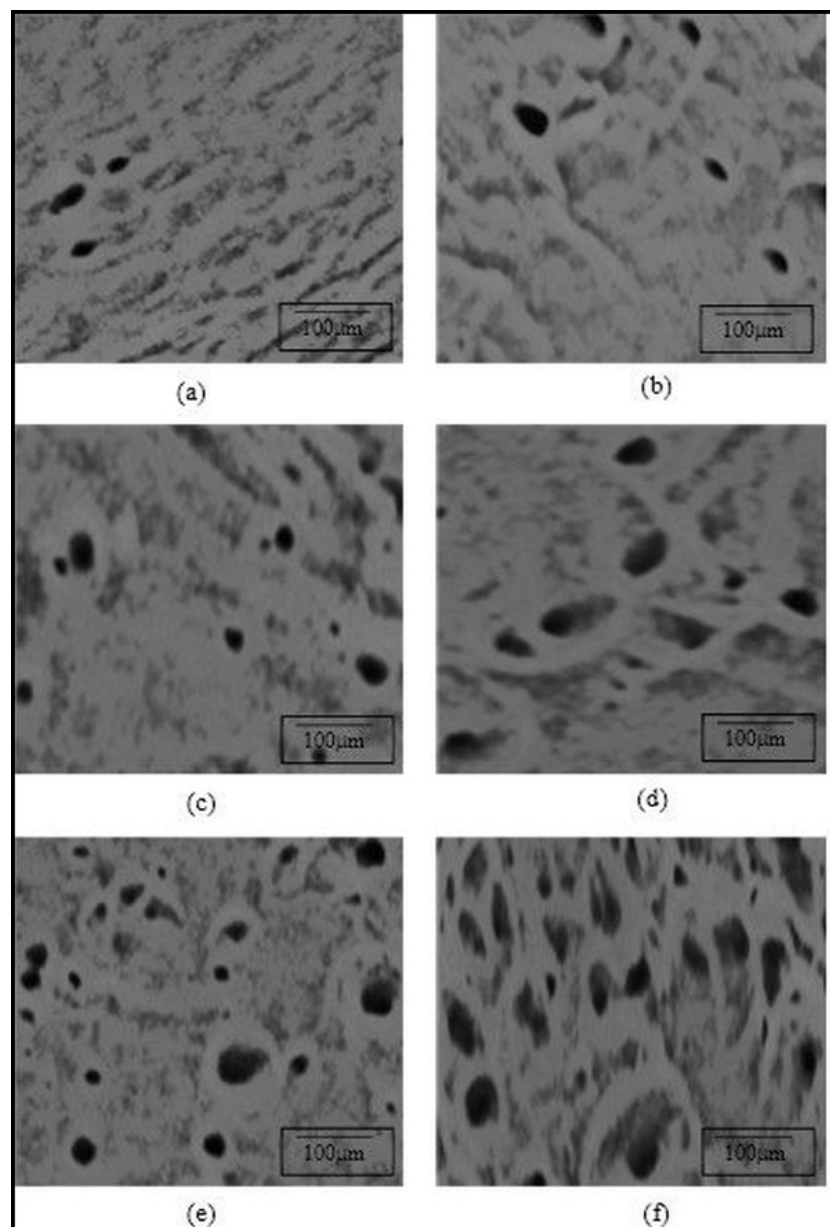
Figure 10. Hydrogen induced blistering on the surfaces of high carbon prestressing steel wire samples with: (a) 0%, (b) 30%, (c) 40%, (d) 50%, (c) 70% and (f) 85% and then plasma hydrogen